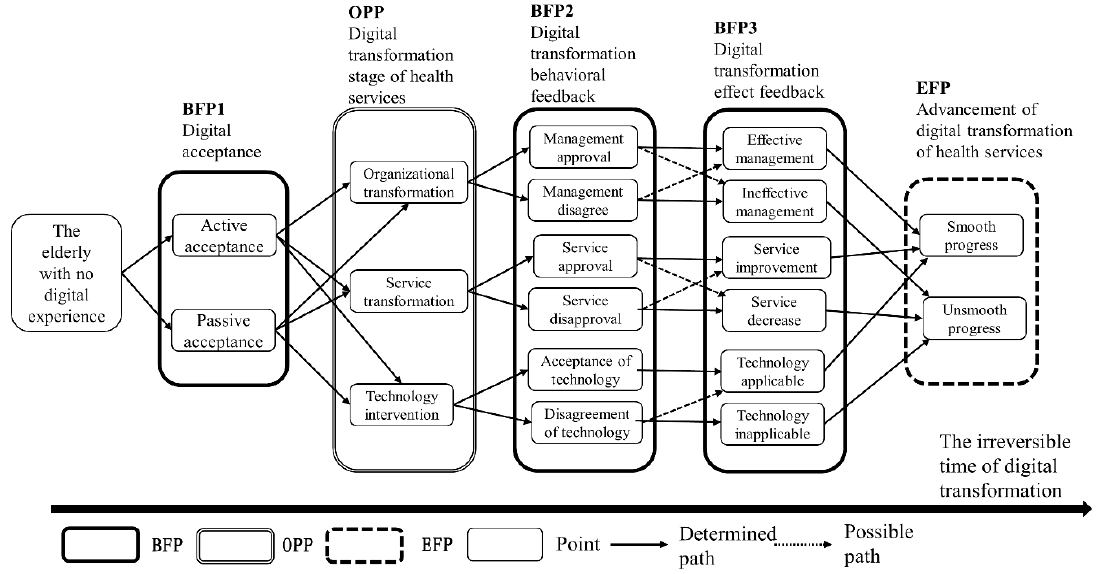
Figure 5. Time-series path of demand-side-based digital health service aging transformation.